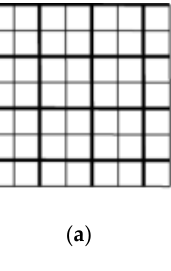
Figure 2. Even ( a ) and odd ( b ) partitioning of the lattice.